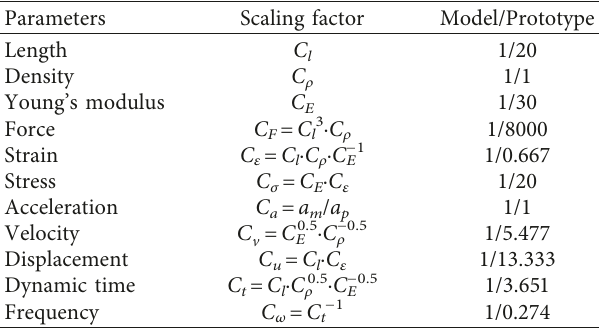
Table 1: Model scaling of physical